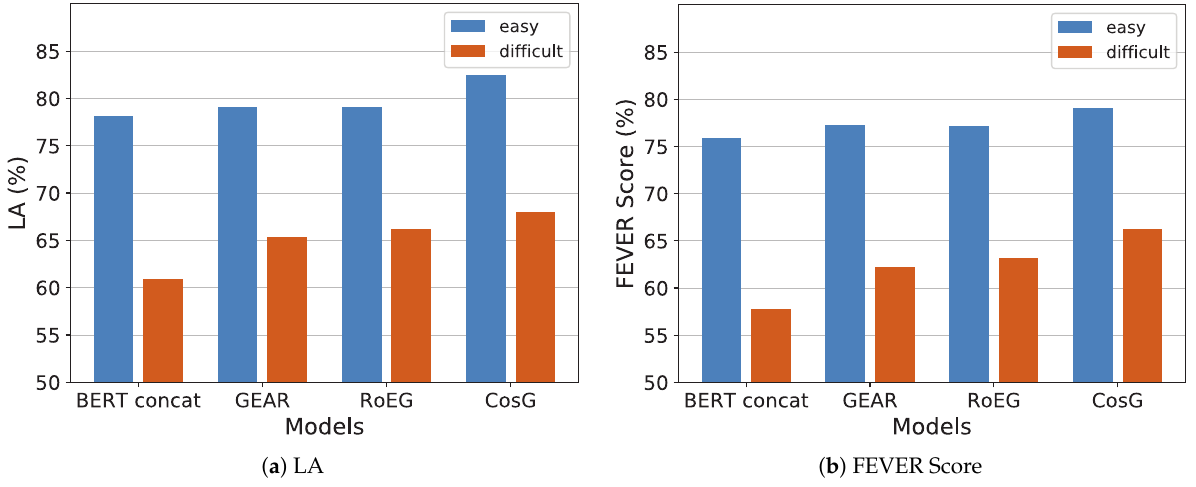
Figure 4. Performance on easy and difficult development sets